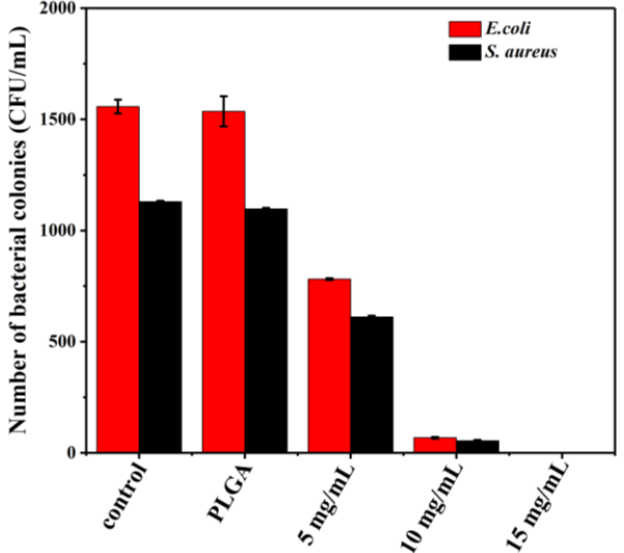
Figure 7. The number of bacterial colonies of E. coli and S. aureus treated with different amounts of thymol-loaded PLGA microparticles (0, 5, 10, and 15 mg/mL). Error bars indicate the standard deviation of the mean.